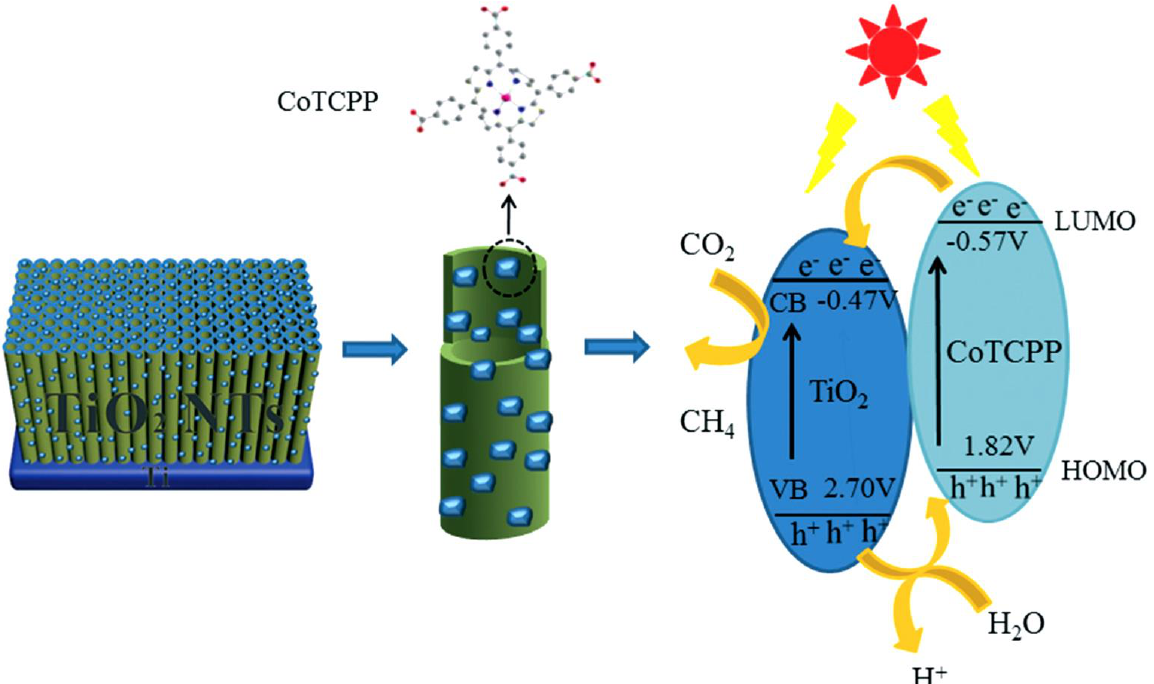
Figure 9. Schematic diagram of possible mechanism for CO 2 photoreduction over sensitized TNT arrays, adopted from